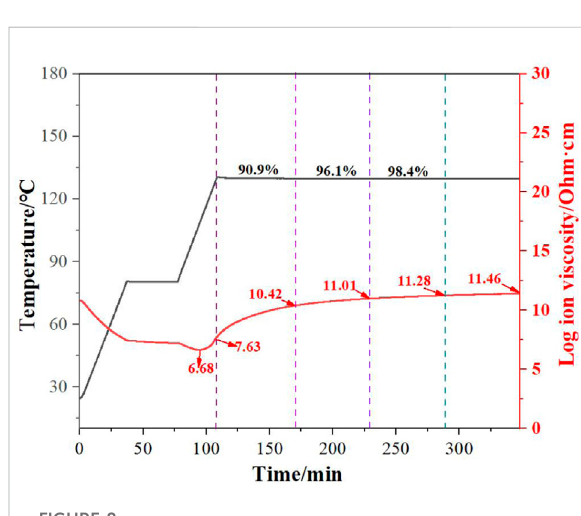
FIGURE 8 The relationship between the dielectric viscosity and the curing process curve of VBO resin